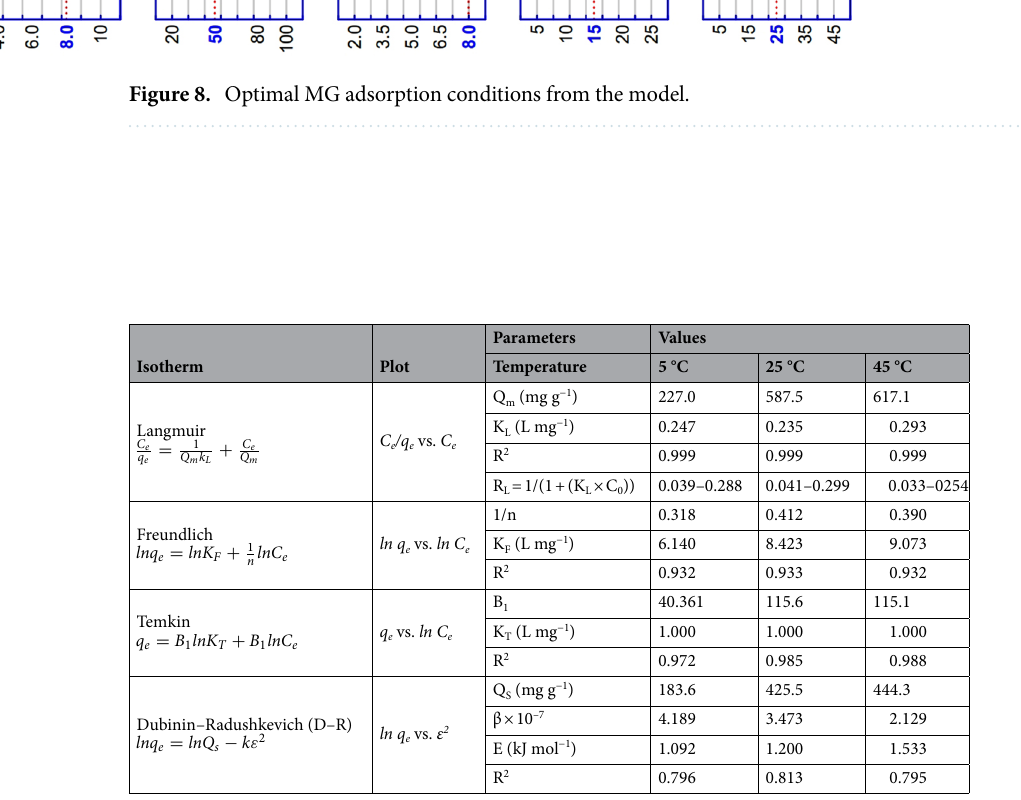
Table 3. Isotherm model parameters for adsorption of MG dye onto meso-CaAl 2 O 4 (volume = 50 mL, adsorbent mass = 8 mg, contact time = 15 min, and pH 8.0).